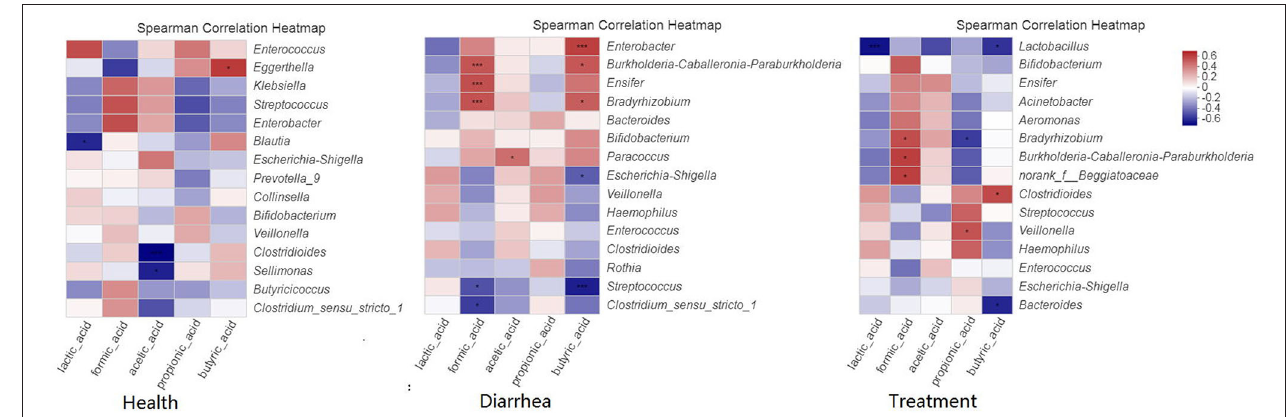
FIGURE 7 | Spearman’s correlation heatmaps of the top 15 genera and SCFAs. The X and Y axes are environmental factors and genus, respectively. * P < 0.05, ** P < 0.01, *** P <